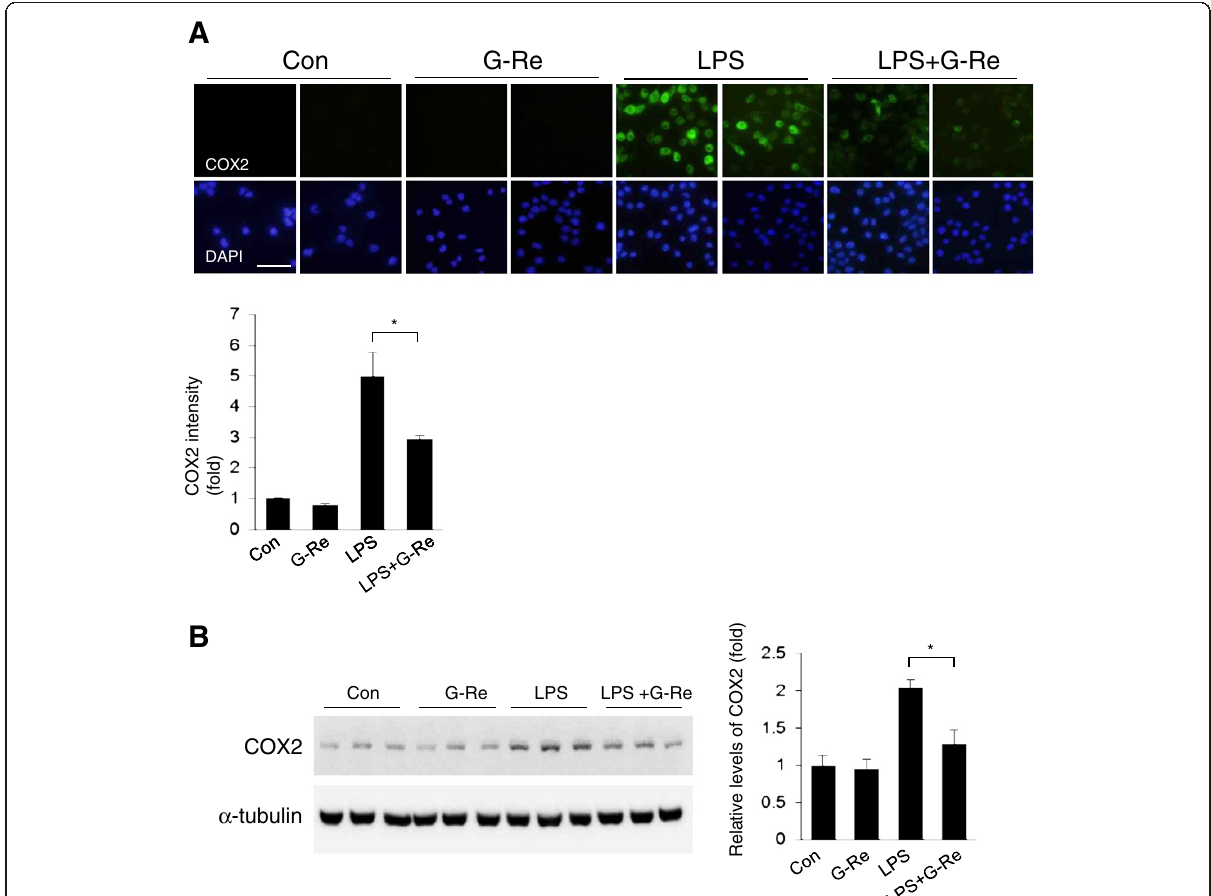
Figure 4 Ginsenosides-Re attenuates the expression levels of COX2 proteins in LPS-induced BV2 microglial cells. ( A ) BV2 cells were pretreated with 2 μ g/ml of G-Re for 1 h, and then stimulated with 1 μ g/ml LPS for 18 h in the presence or absence of 2 μ g/ml G-Re. Cells were visualized using immunofluorescence microscopy with antibody for COX2. Quantification of COX2 expression density by Image J is shown on the right (n = 5 for each of the four groups.) (bars: 50 μ m.) * p < 0.05, ** p < 0.01. ( B ) Western blots were performed using an antibody against COX2. The loading control for the cell lysates was determined by re-probing the membranes with α -tubulin antibody. The values shown are the mean ± S.E.M. of data obtained from three independent experiments. * p < 0.05, ** p <